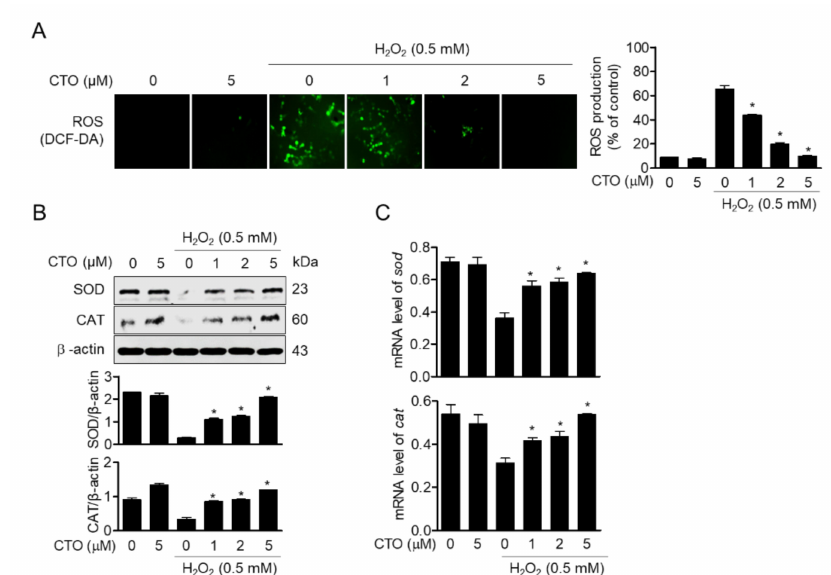
Figure 3. CTO suppresses ROS production by inducing superoxide dismutase (SOD) and catalase (CAT) in SW1353 cells. ( A ) The cells were pre-treated with the indicated concentrations of CTO for 6 h, and then stimulated with or without 0.5 mM H 2 O 2 for 2 h. The cells were incubated at 37 ◦ C in the dark for 20 min with culture medium containing 2 µ M 2 (cid:48) , 7 (cid:48) -dichloroflourescin diacetate (DCF-DA) to monitor reactive oxygen species (ROS) production. The degree of ROS production was measured by fluorescence microscope. ( B ) The expression of SOD and CAT proteins were measured by Western blot analysis from cells pre-treated with CTO and stimulated by 0.5 mM H 2 O 2 . ( C ) The mRNA level of these genes was measured by real-time PCR. * p < 0.05 was considered significant compared to only H 2 O 2 treat group.